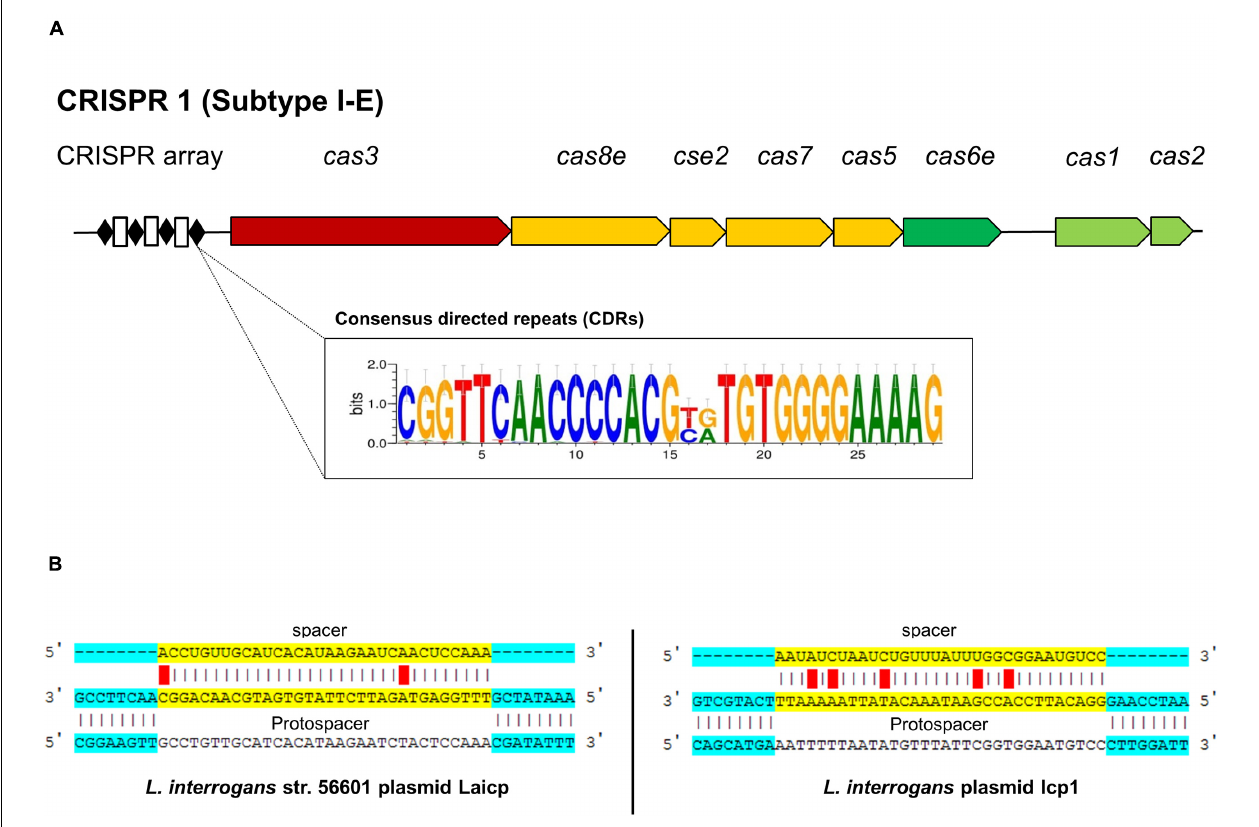
FIGURE 3 | CRISPR-Cas gene organization in the L. weilii serogroup Mini strains CUDO6 and CUD13. Both L. weilii strains contained CRISPR1 subtype I-E with an uncoupled CRISPR array region located upstream of the locus (A) . The CRISPR arrays harbor both of the consensus directed repeats (black diamond) and spacers (white rectangle). Strains CUDO6 and CUD13 carried two different consensus directed repeats, as shown in the sequence logo box (A) . DNA sequences in the spacers are transcribed into CRISPR RNA (crRNA) and targeted to the protospacer of invaded foreign DNA. The spacers of strains CUDO6 and CUD13 have the highest matching score to the protospacer of Leptospira plasmid Laicp and lcp1 (B) .